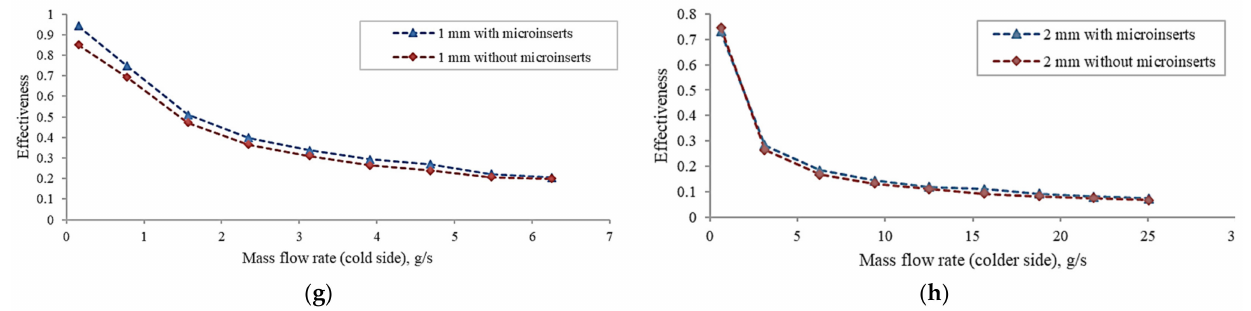
Figure 5. Variation in different parameters with mass flow rate for 1 mm and 2 mm channel